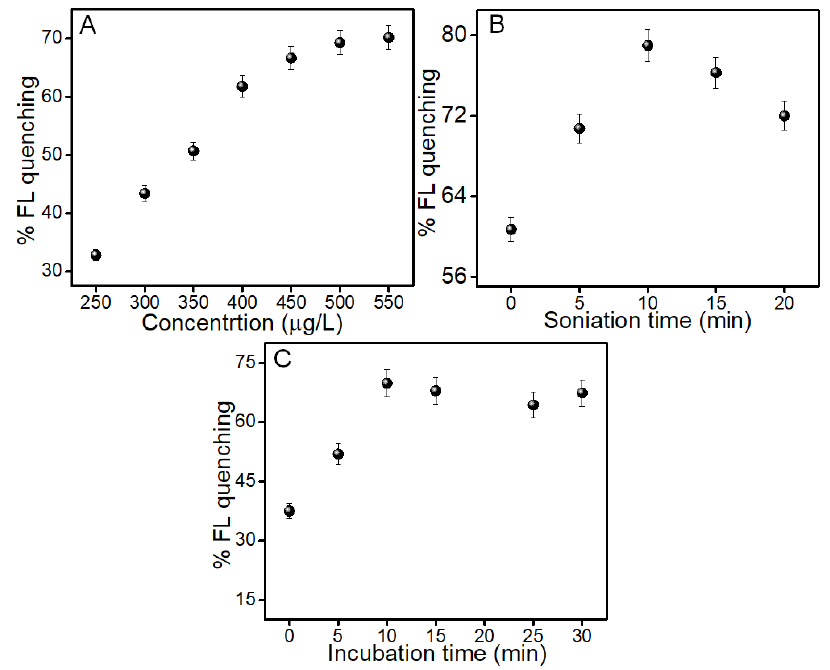
Figure 5. Effects of ZnSe-B6 concentrations (250 – 550 µg/L) ( A ), sonication time ( B ) and incubation ( C ) on the quenching (% FL) in the presence of Rh-B (160 ng/L).